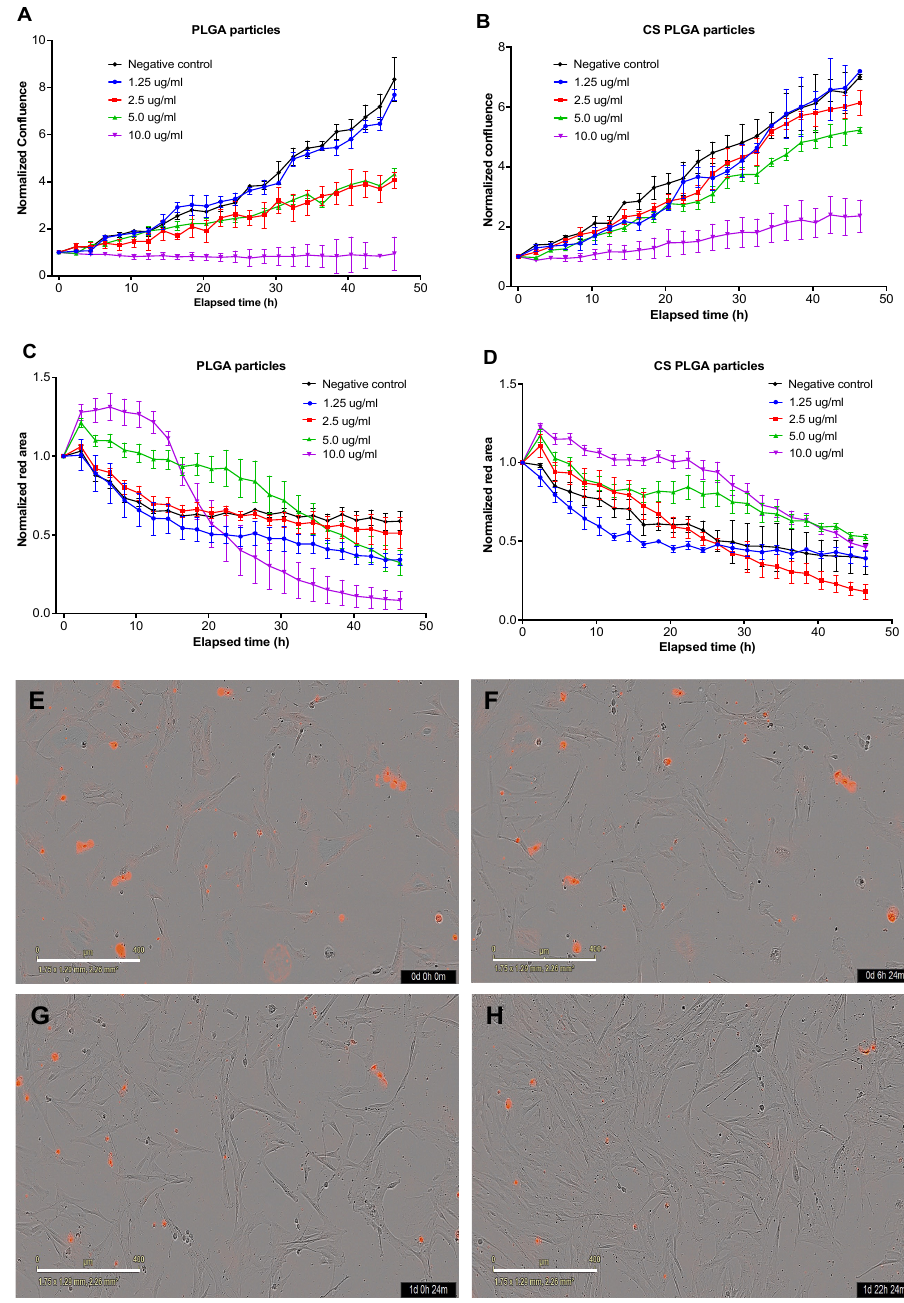
Figure 11. Live cell imaging (IncuCyte) analysis showing cellular proliferation ( A , B ) and cytotoxic- ity ( C , D ). The results show the effect of treatment of bovine intestinal FKD-1-R cells with uncoated or CS-PLGA particles encapsulating the indicated EO components measured at 3 h intervals for 48 h. The normalized results of the mean cell confluence or values of red areas ± standard errors were plotted in curves produced by the integrated IncuCyte software against the elapsed time. ( E – H ) Representative images (10x objective) show the degree of proliferation and red fluorescent areas in wells treated with 1.25 μ g/mL for 0, 6, 24 and 48 h, respectively. Scale bars = 400 μ m.